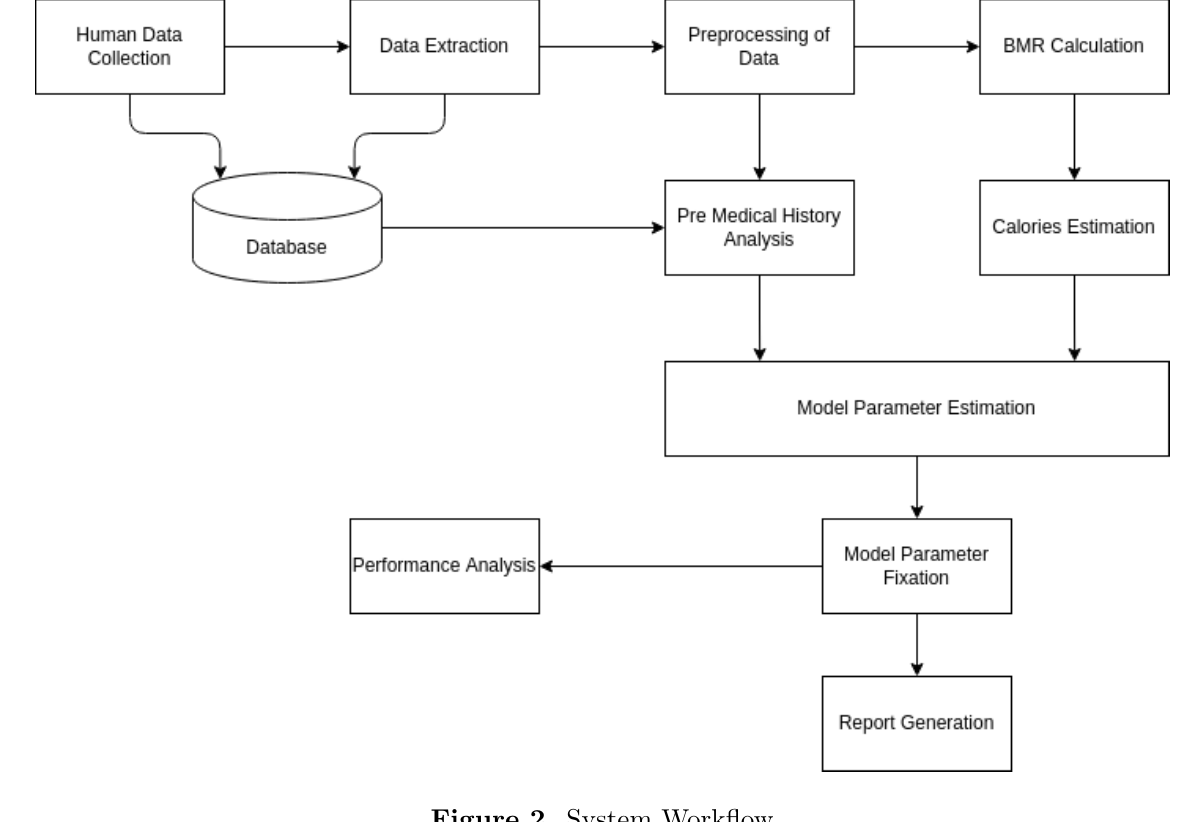
Figure 2. System